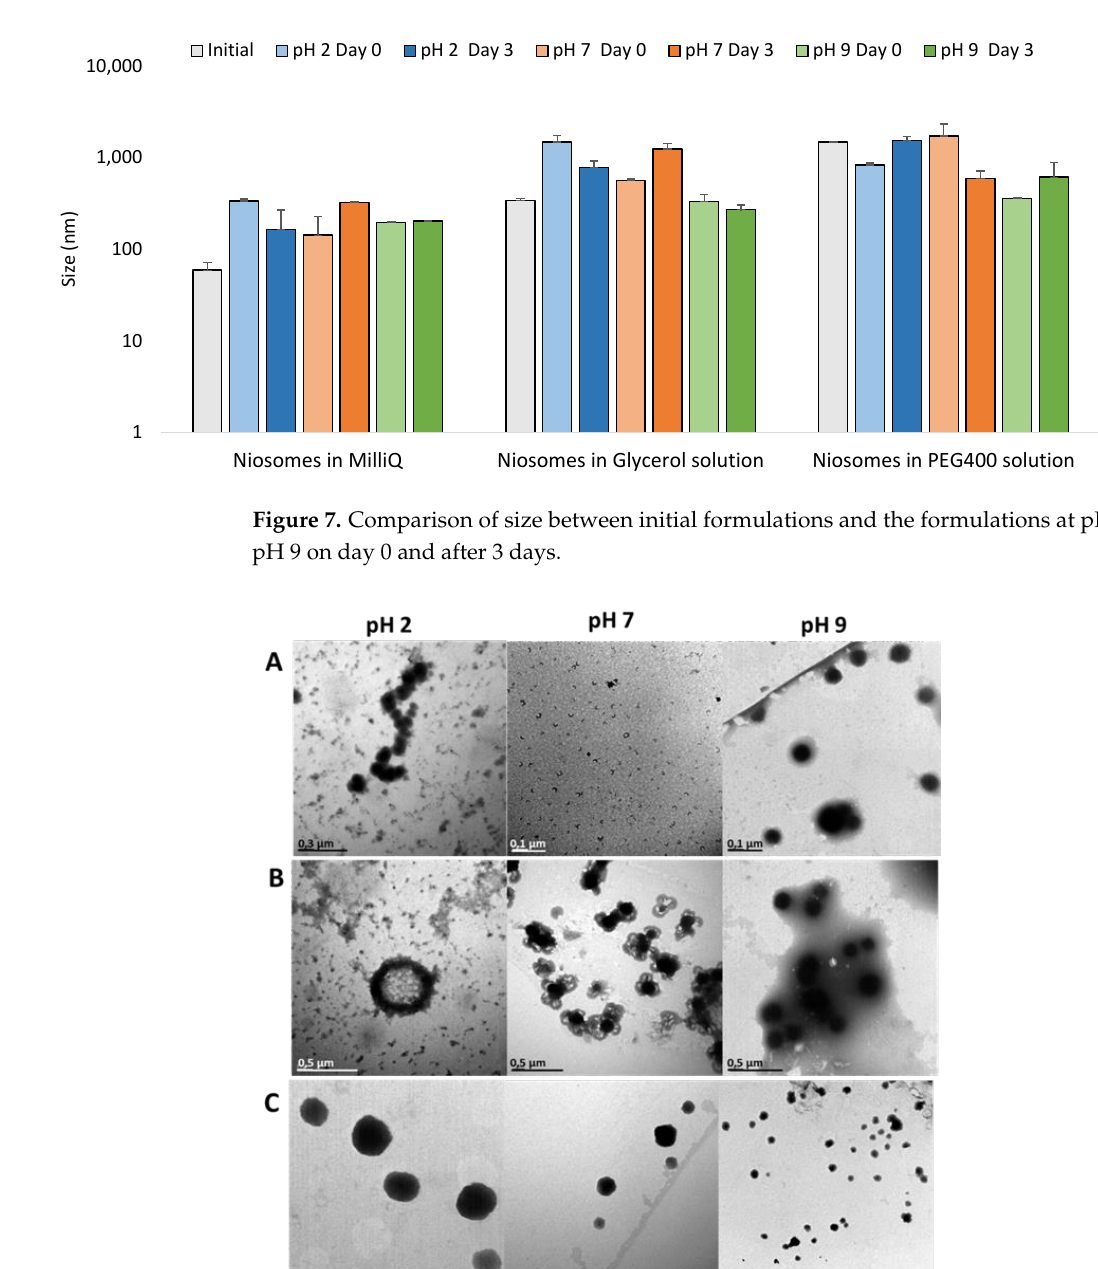
Figure 8. Images obtained from HR-TEM of niosomes at pH 2, 7, and 9. ( A ) Niosomes with rifamycin S encapsulated in MQ water as aqueous phase; ( B ) Niosomes with rifamycin S encapsulated in mixture of MQ water and glycerol (60:40 v / v ); ( C ) Niosomes with rifamycin S encapsulated in mixture of MQ water and PEG 400 (44.7:55.3 v / v ). Table 4. Physical properties of vesicles hydrated in three aqueous phases at natural pH and at other pHs (2, 7, 9), fresh and after 3 days under storage.